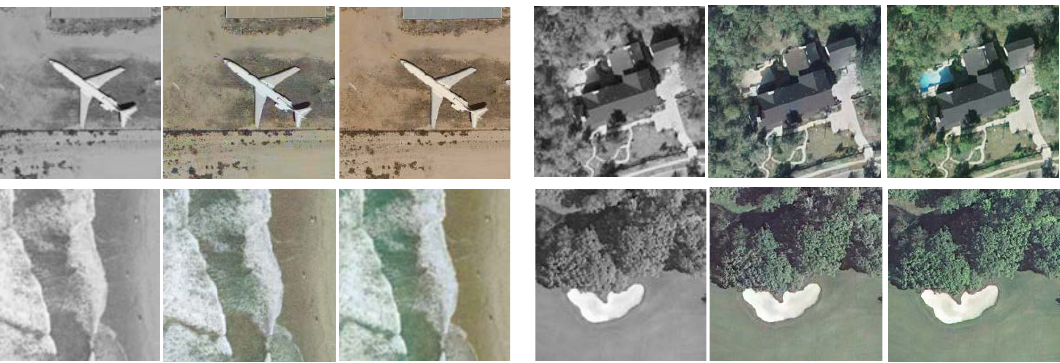
Figure 13. Example artificial colorization of satellite images: grayscale images ( left ), colorful images ( middle ) and ground truth ( right